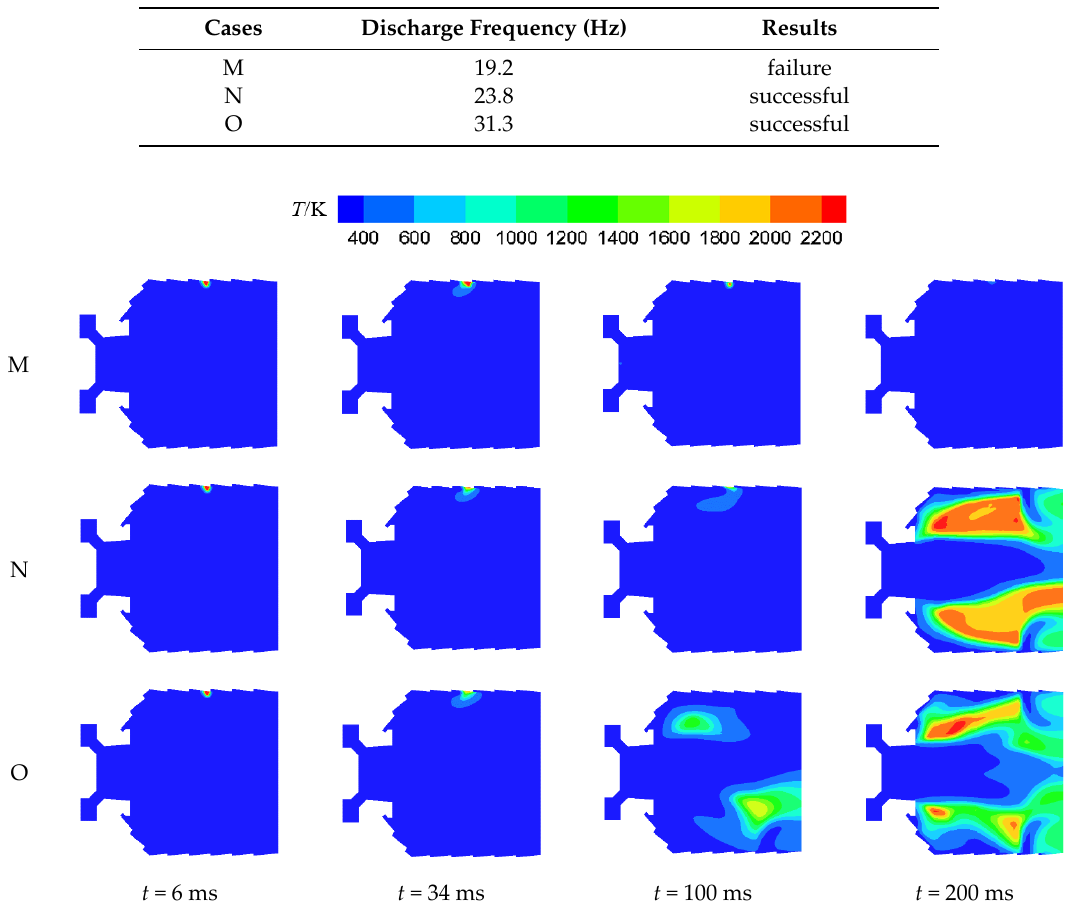
t = 200 ms Figure 15. Numerical temperature field of combustor cross section (X = 130 mm) in Cases M–O. 0 . 00